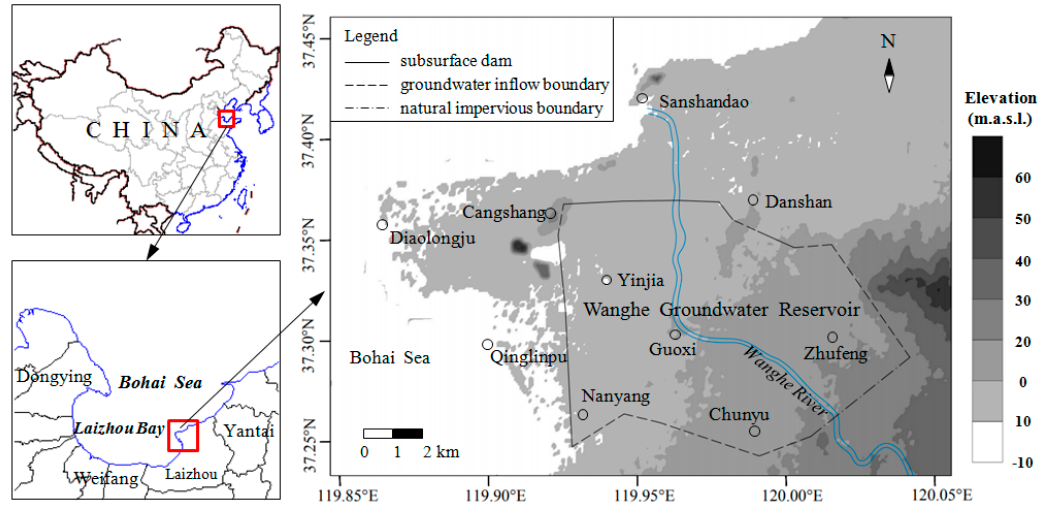
Figure 1. Location of study area and Wanghe artificial underground reservoir.